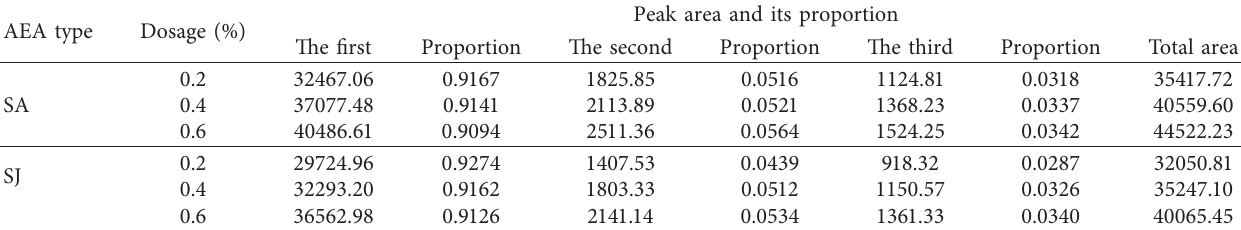
Table 5: T 2 spectral peak areas and their proportions of AEACPB samples doped with different AEA. Peak area and its proportion AEA type Dosage (%) The first Proportion The second Proportion The third Proportion Total